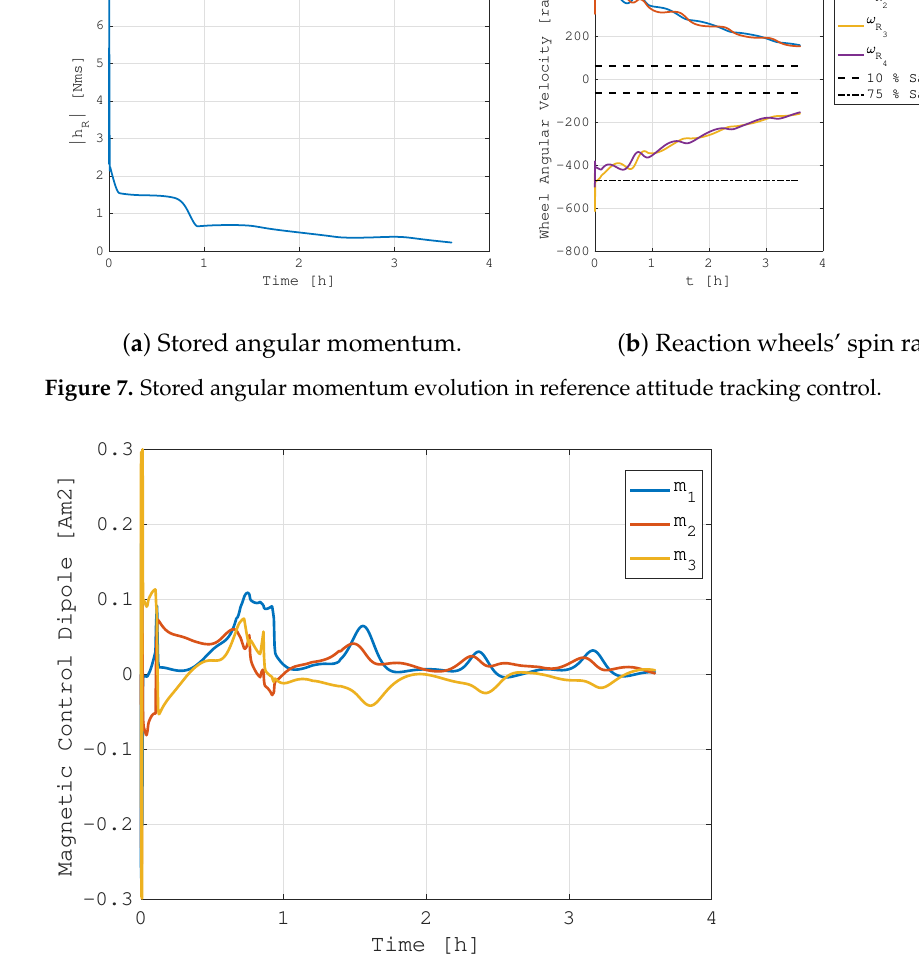
Figure 8. Actuated magnetic dipole in reference attitude tracking